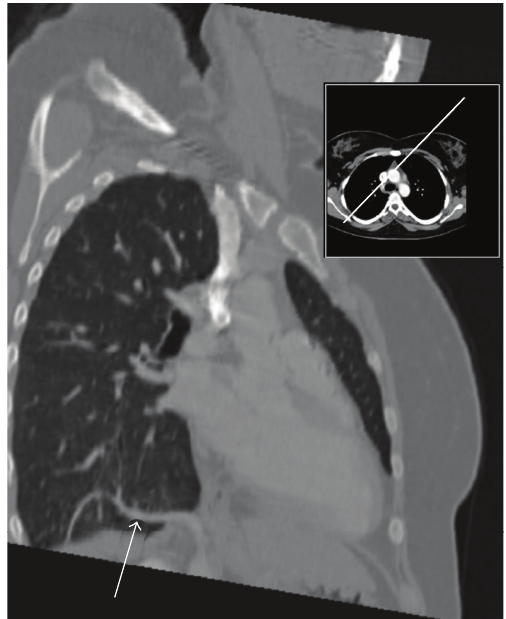
Figure 1: Aberrant arterial supply (white arrow) to intralobar pulmonary sequestration in right lower lung.